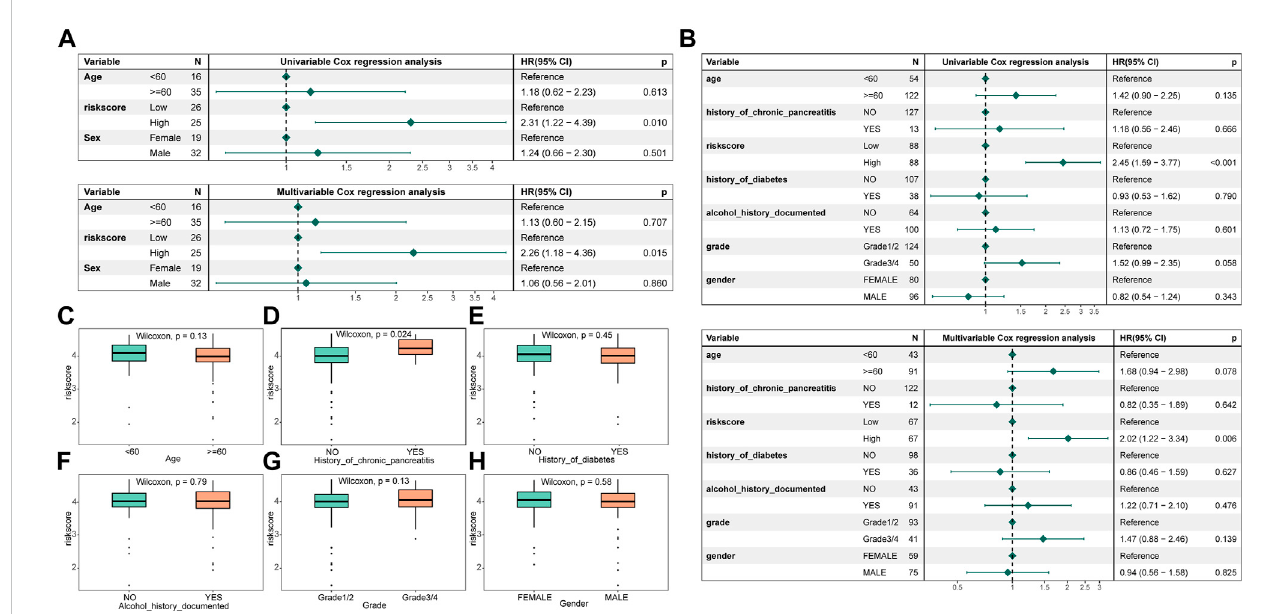
FIGURE 6 Risk assessment model construction and correlation of clinical characteristics with different groups. (A) Forest map of univariable and multivariate cox factors in the training set; (B) Forest map of univariable and multivariate cox factors in the validated set; (C – H) Risk scores in different clinical characteristics (age, history of chronic pancreatitis, history of diabetes, history of alcohol documented, grade, and gender,